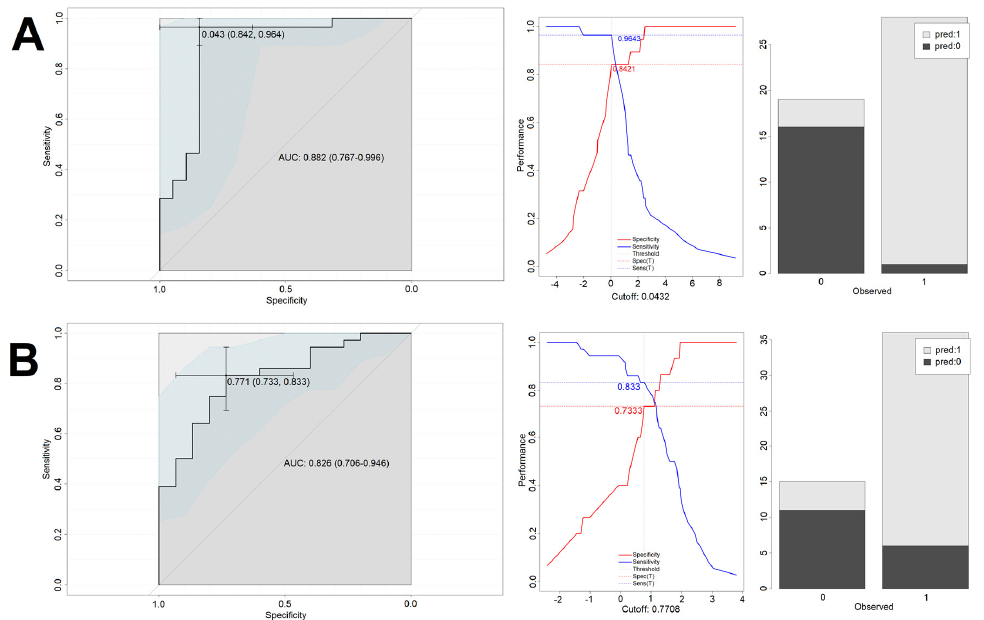
Figure 5. Performance of the cortisol-based model with confounding factors on the training set. Left column depicts the ROC curves of the logistic regression models. Middle column presents analysis of balance between sensitivity and specificity, which was used to determine the optimal cut-off level. Right column shows the accuracy of predictions on the training set based on the determined cut-off. X -axis describes the real outcomes. Colors describe the predicted outcomes. Y -axis depicts counts. 0—Lack of endpoint fulfillment; 1—endpoint fulfillment. ( A ) NGCG group. ( B ) GCG